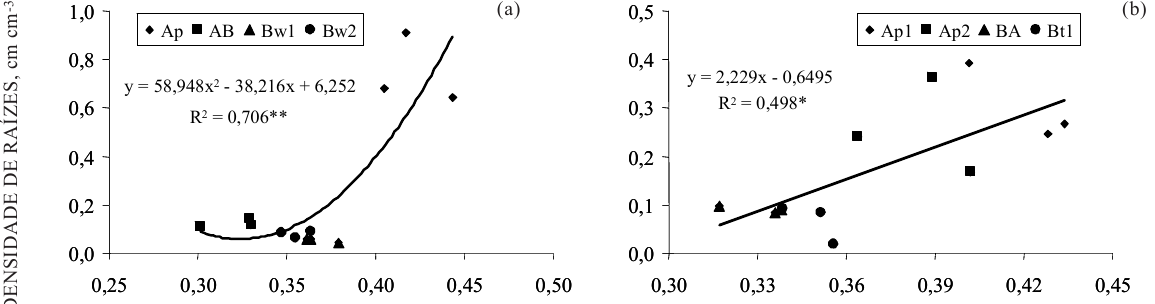
Figura 4. Relação entre densidade de raízes de citros e porosidade total (PT), em Latossolo Amarelo (a) e Argissolo Acinzentado (b) de Tabuleiros Costeiros da Bahia, na avaliação de indicadores de horizontes